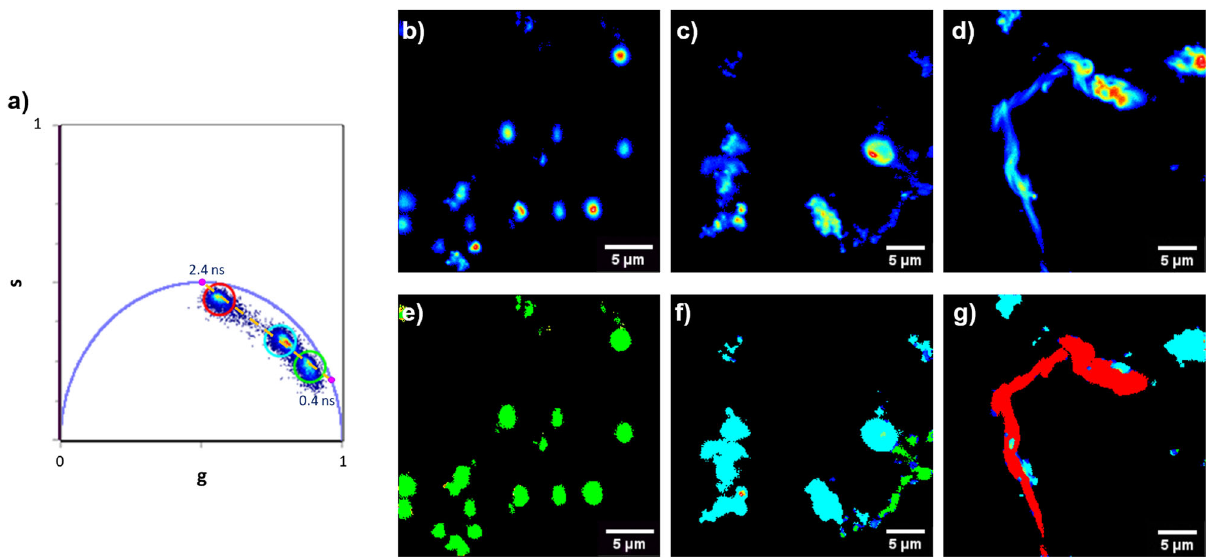
Fig. 3 Coacervation of Pvfp-5 β in alkaline environment. Phasor analysis of 256 × 256 pixels FLIM measurements on ThT signal of 1 mg/ml Pvfp-5 β in 0.1 M Tris-HCl pH 8, 1 M NaCl. a Phasor plot obtained from images of the different species present in the sample. The coordinates g and s correspond to sine and 30 cosine transforms of each point in the phasor plot, respectively. Three distinguishable lifetime distributions, highlighted by colored circular cursors, are evident and lay on a straight line (dashed yellow) connecting two mono-exponential decays phasors with characteristic lifetime of 2.4 ns and 0.4 ns. b , c , d Fluorescence intensity images, from low intensity (blue) to high intensity (red) of coacervate droplets, medium size aggregates and fi bril, respectively. e , f , g Lifetime maps: each pixel is colored according to the corresponding color code of the cursor highlighting the lifetime distributions in the phasor plot a).